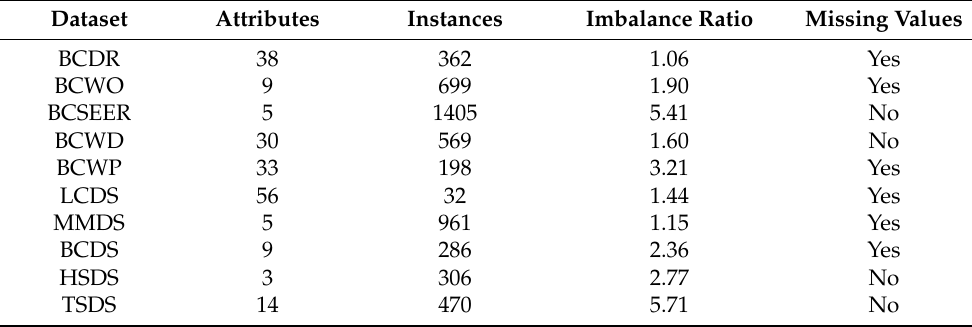
Table 1. Summary of the characteristics of the